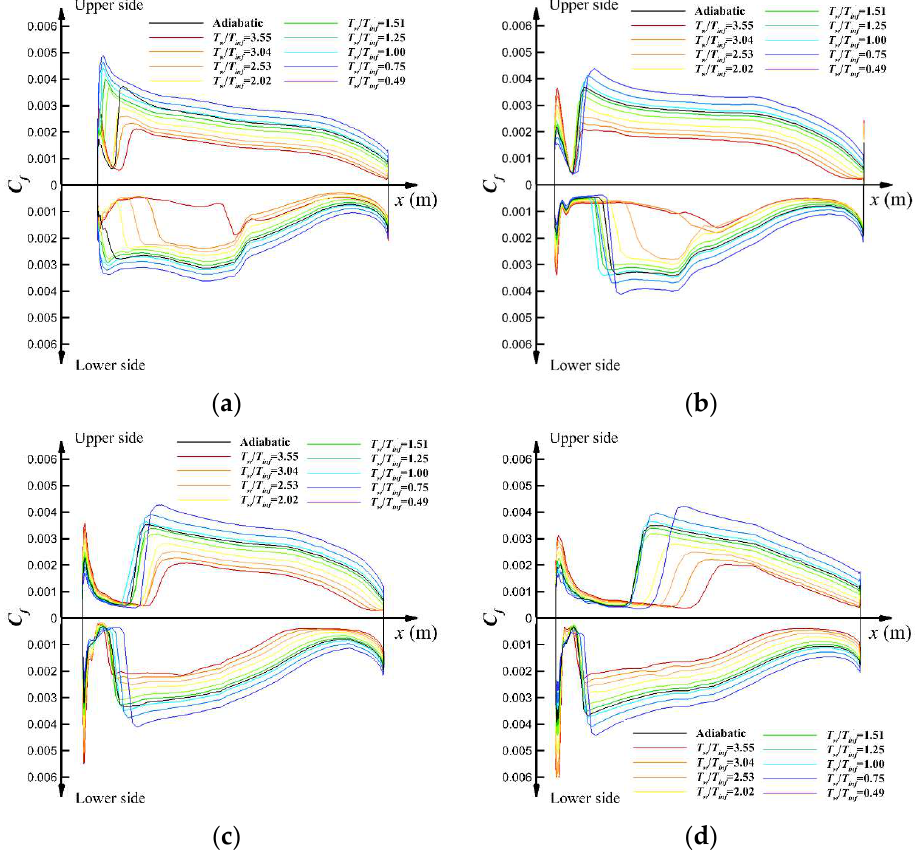
Figure 14. Skin-friction of different slices of the wing. ( a ) Slice at 0.1b; ( b ) slice at 0.225b; ( c ) slice at